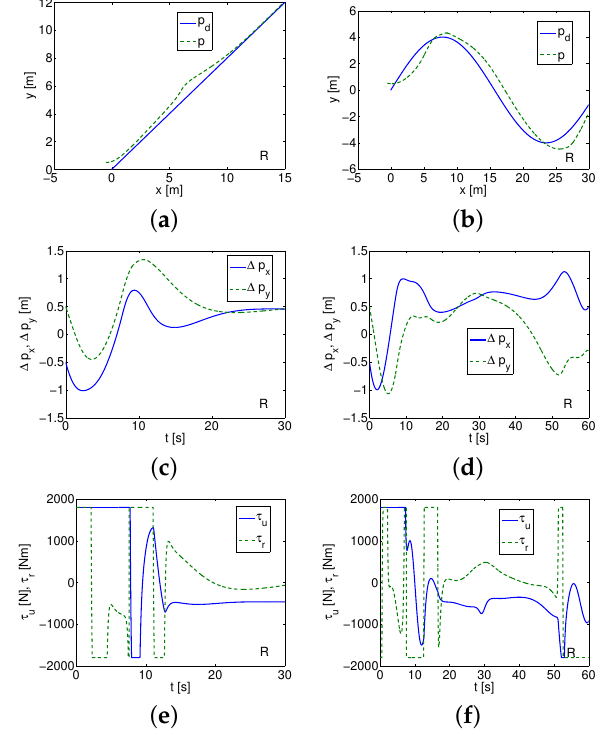
Figure 7. Simulation results for ROPOS (sliding mode controller (SMC))—linear and sine trajectory. ( a , b ) Desired and realized trajectory; ( c , d ) position errors; ( e , f ) applied